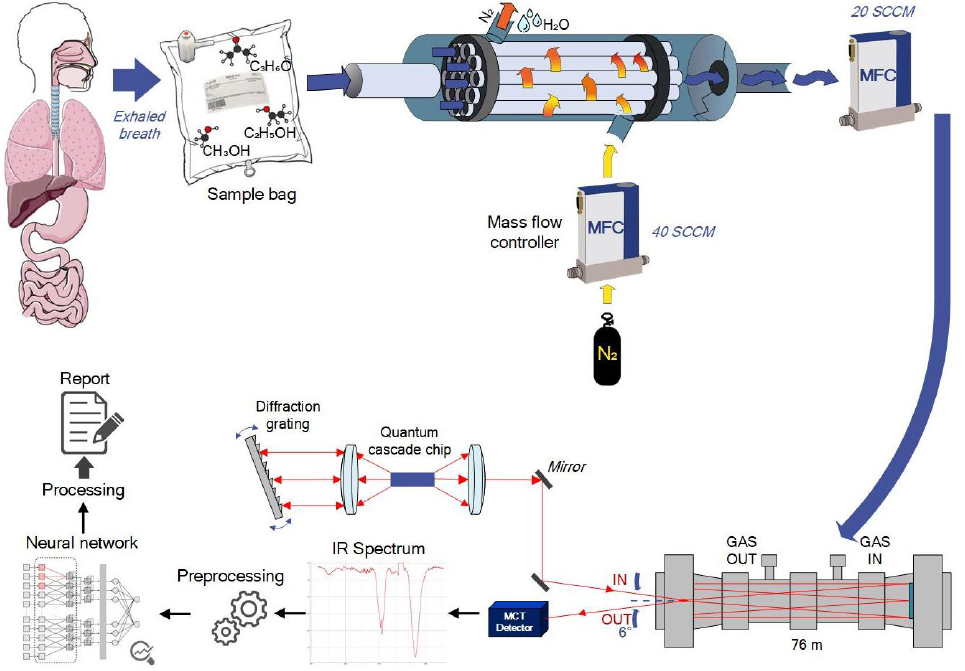
Figure 2. Basic scheme for breath sample analysis method.